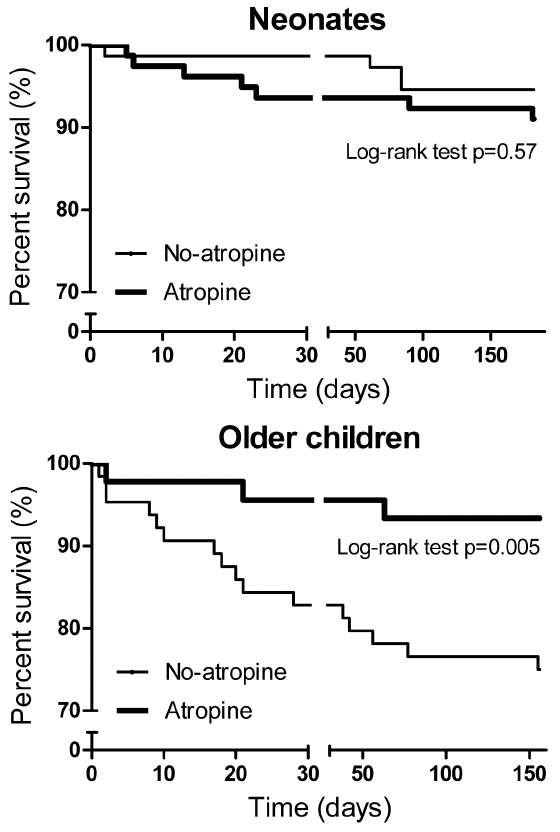
Figure 2. Kaplan-Meier plots for mortality in the two age sub- groups of neonates and older children.